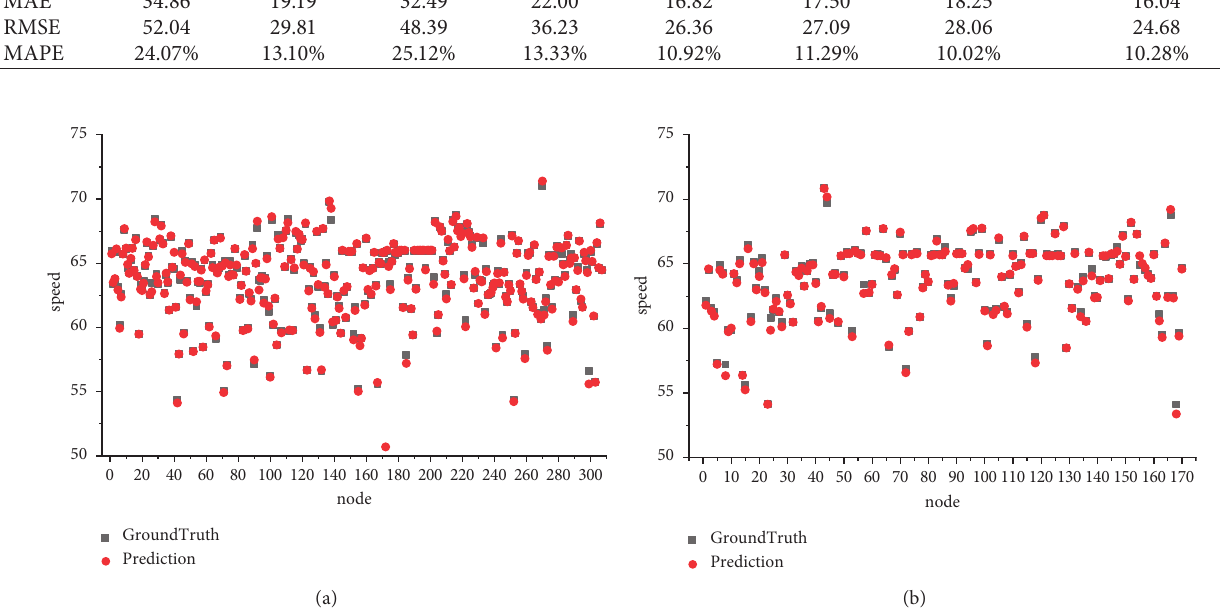
Figure 10: The real values and predicted values for all nodes on (a) PeMSD4 and (b) PeMSD8.